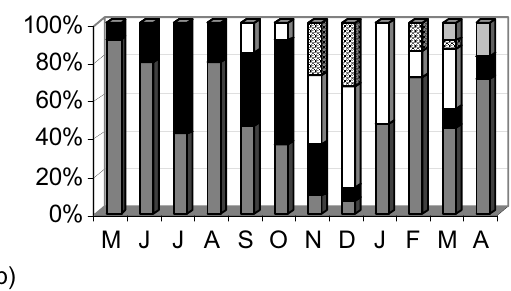
Fig. 4. Monthly variation of the gonadal maturation stages of Gymnotus aff. carapo in lagoa Verde, Itapuã State Park. (a) Males, (b) Females.